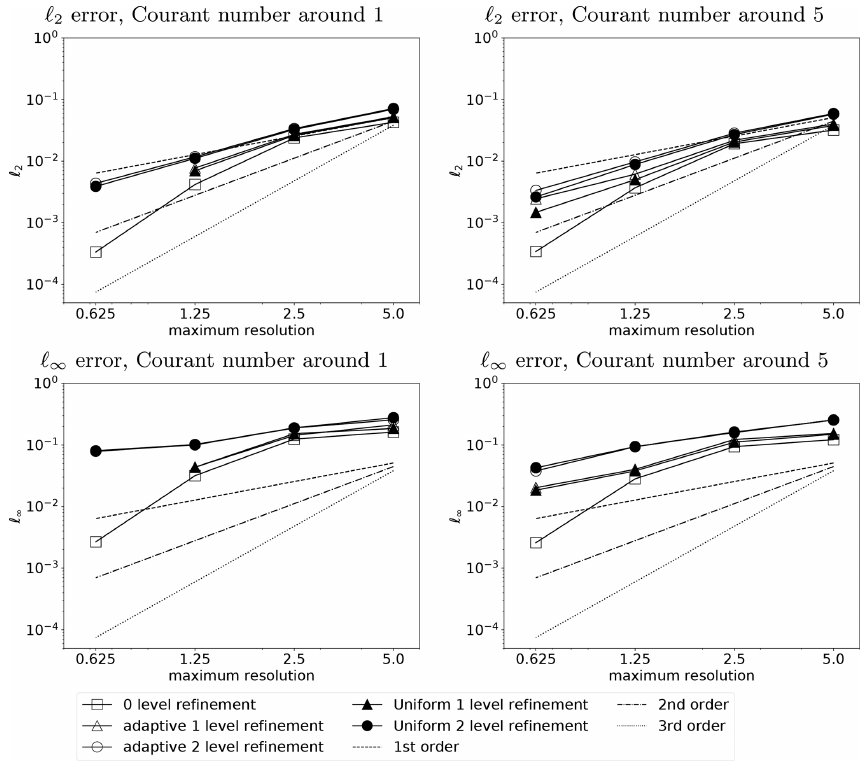
Figure 19. Convergence rate of the numerical results in the moving vortices test case on adaptive meshes using a coarse initial condition and interpolated wind except for zero-level